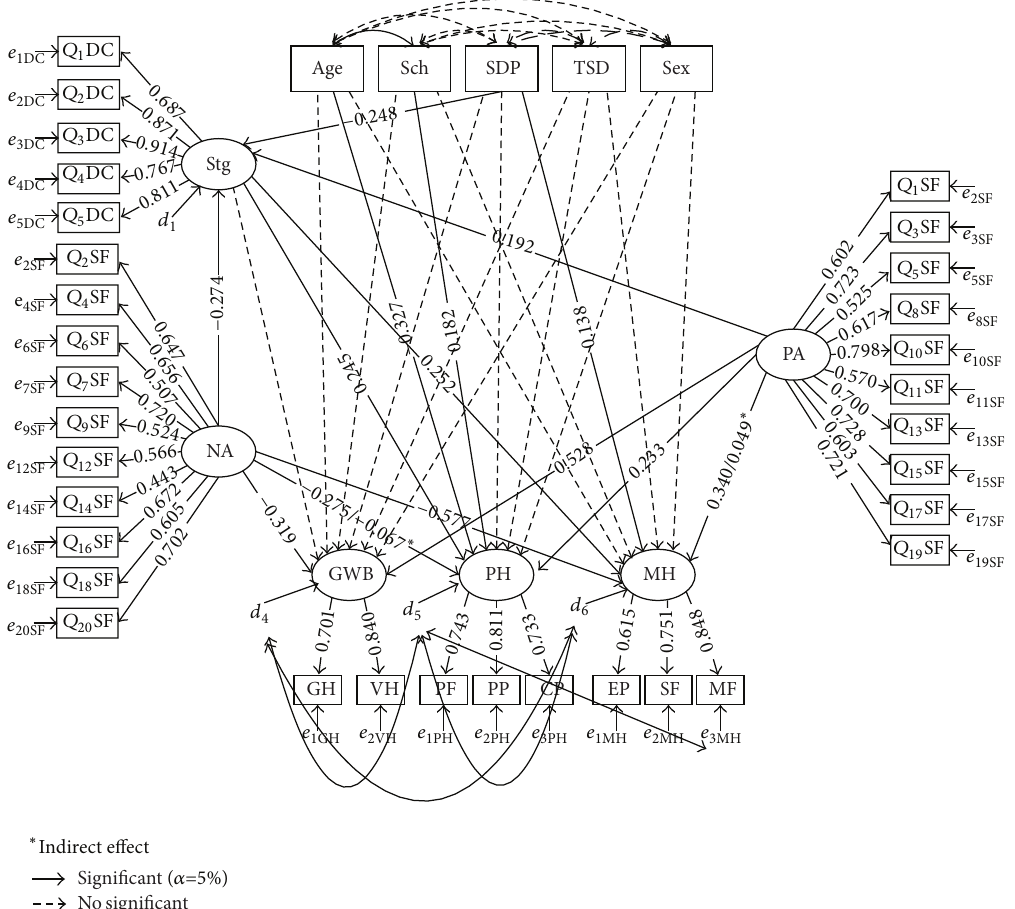
Figure 2: Standardized estimates: Structural Equation Model. Age: age; Sch: education; SDP: severity of disease perception; TSD: time since diagnosis; Sex: sex; Stg: stigma; NA: negative affect; PA: positive affect; GWB: general well-being; PH: physical health; MH: mental health.